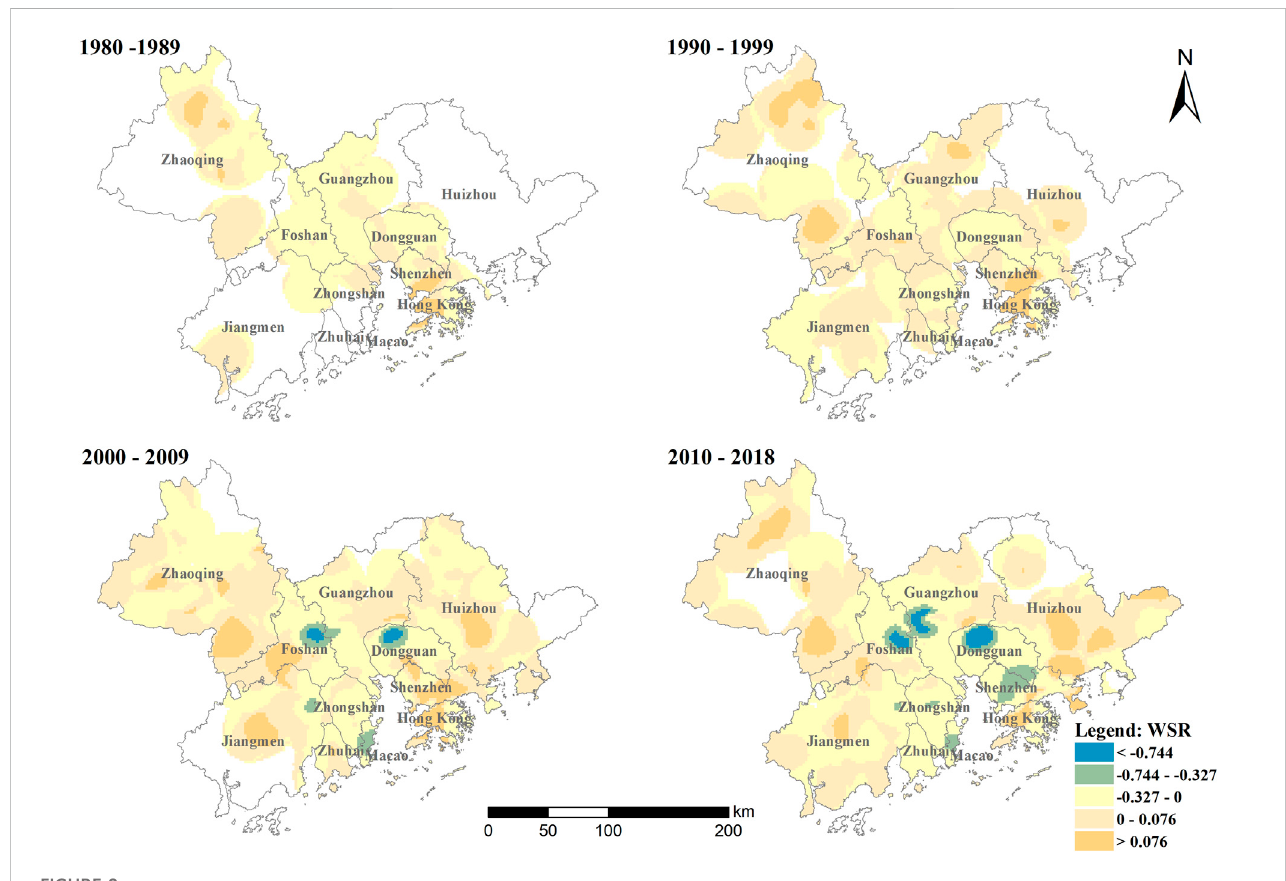
FIGURE 8 Spatial distribution of regression coef fi cients for WSR during 1980 –